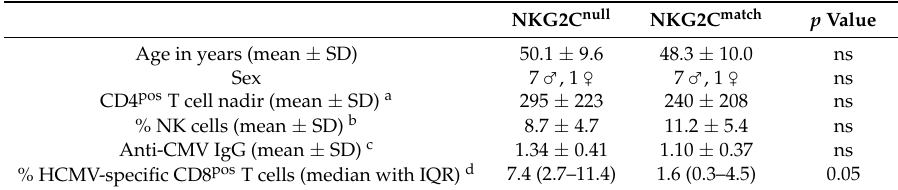
Table 1. Characteristics of HIV-infected NKG2C null and matched control